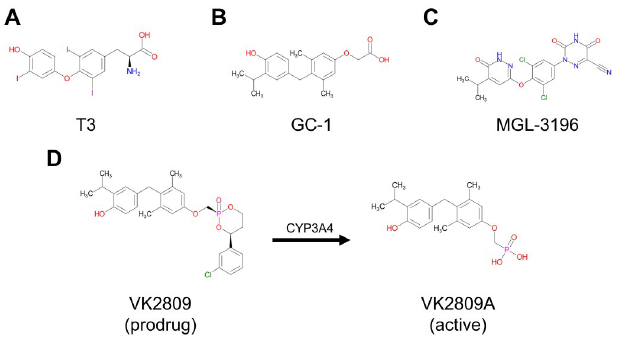
Fig 1. Chemical structures of test compounds. Chemical structures of (A) the natural THR ligand triiodothyronine, T3, (B) sobetirome, GC-1, (C) resmetirom, MGL-3196, (D) VK2809, and VK2809A, which is produced by CYP3A- mediated cleavage of VK2809 after first pass intrahepatic